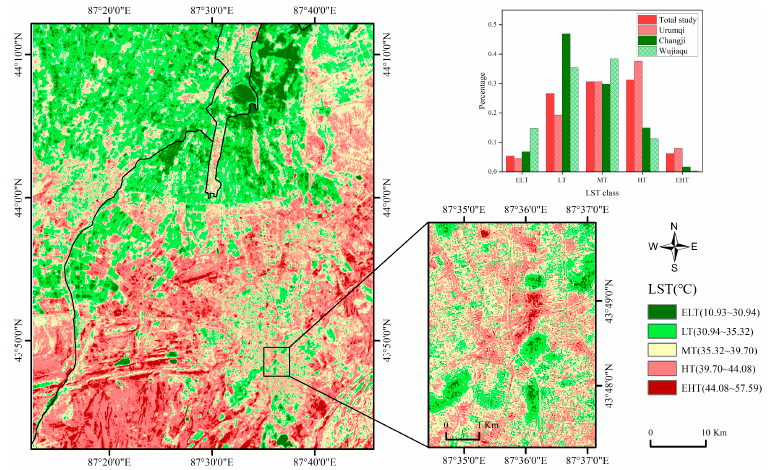
Figure 6. Urumqi–Changji–Wujiaqu metropolitan area LST10m distribution map.